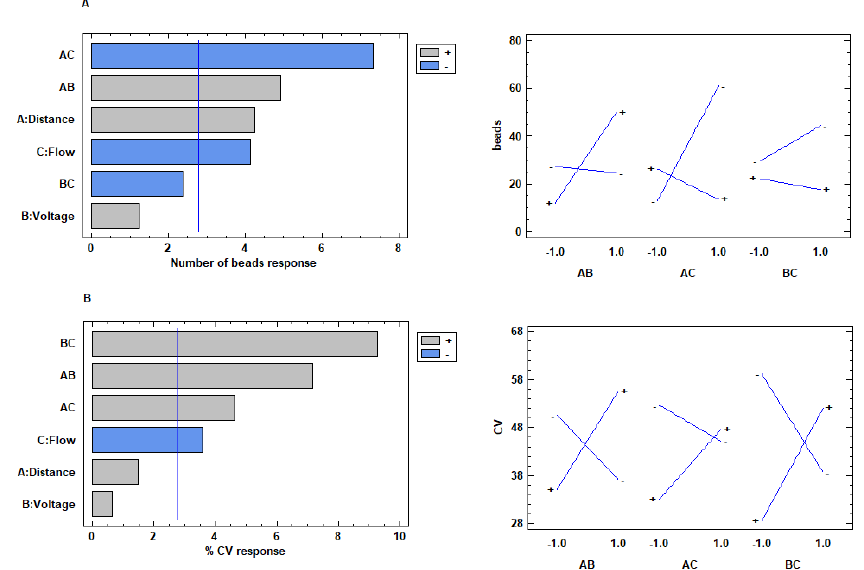
Figure 4. Effects of the considered process parameters (on the left) and interaction plots (on the right) for ( A ) “Number of beads” response for 1:1 (w/w) collagen/PCL fibers and ( B ) “Coefficient of variation (% CV)” response for collagen/PCL 1:2 (w/w) fibers.